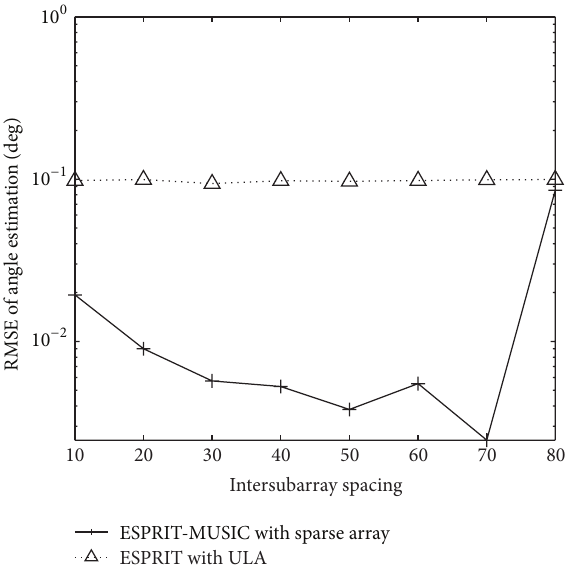
Figure 2: RMSE of angle estimation of the first target with different intersubarray spacing with SNR = 4